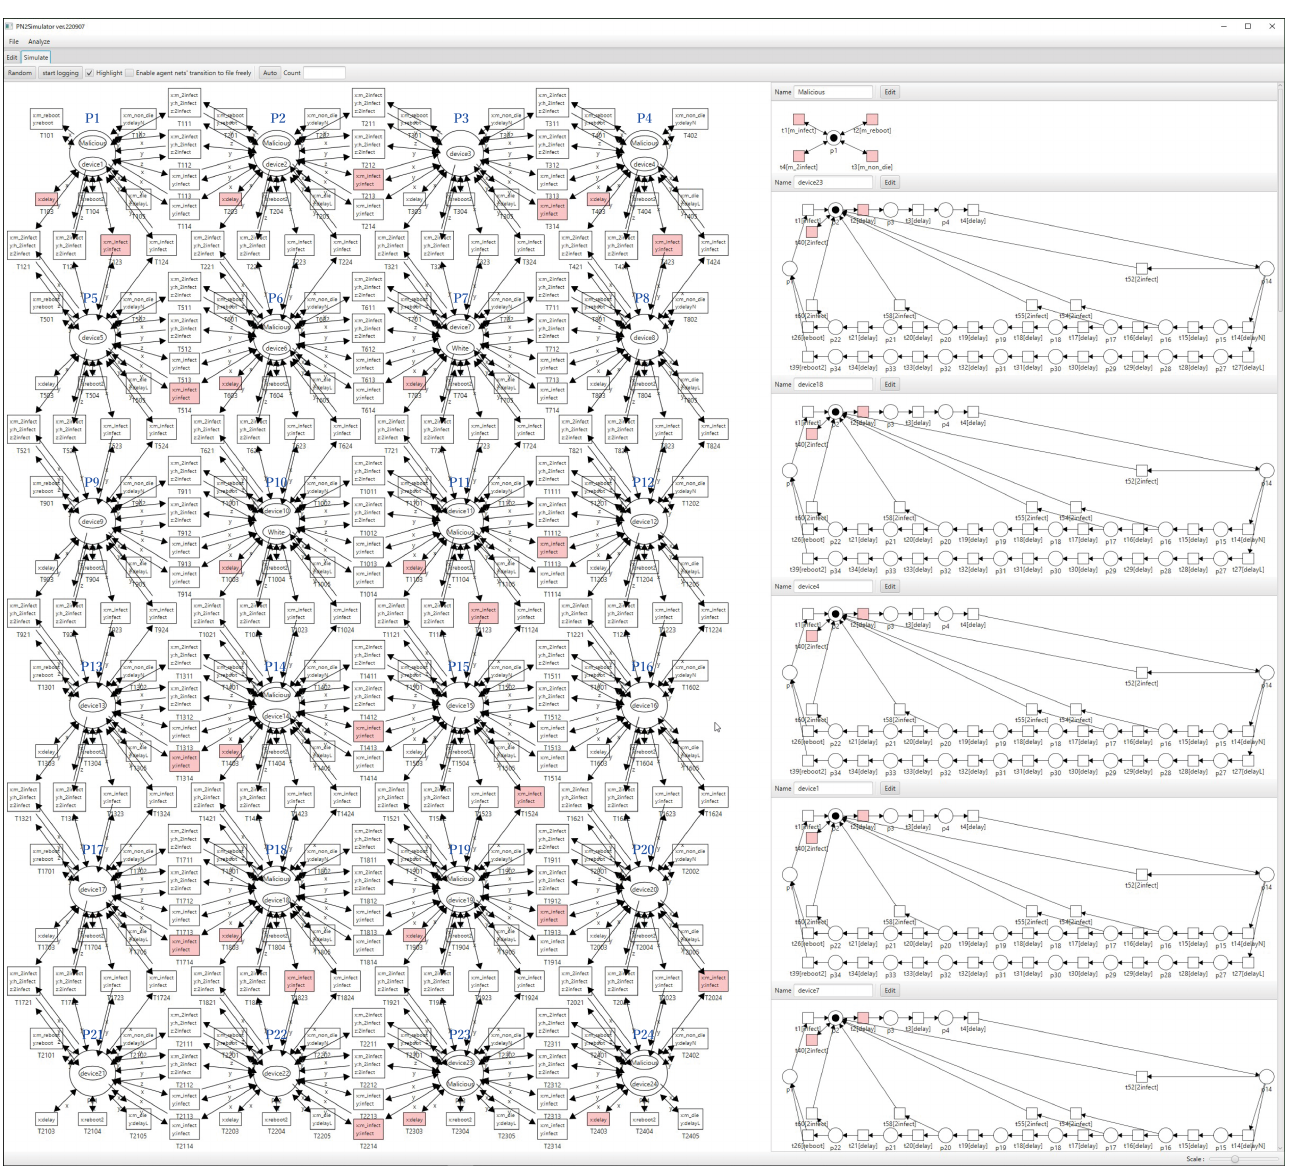
Figure 7. A screenshot of the PN2Simulator, which displays the PN 2 model representing the state shown in Figure